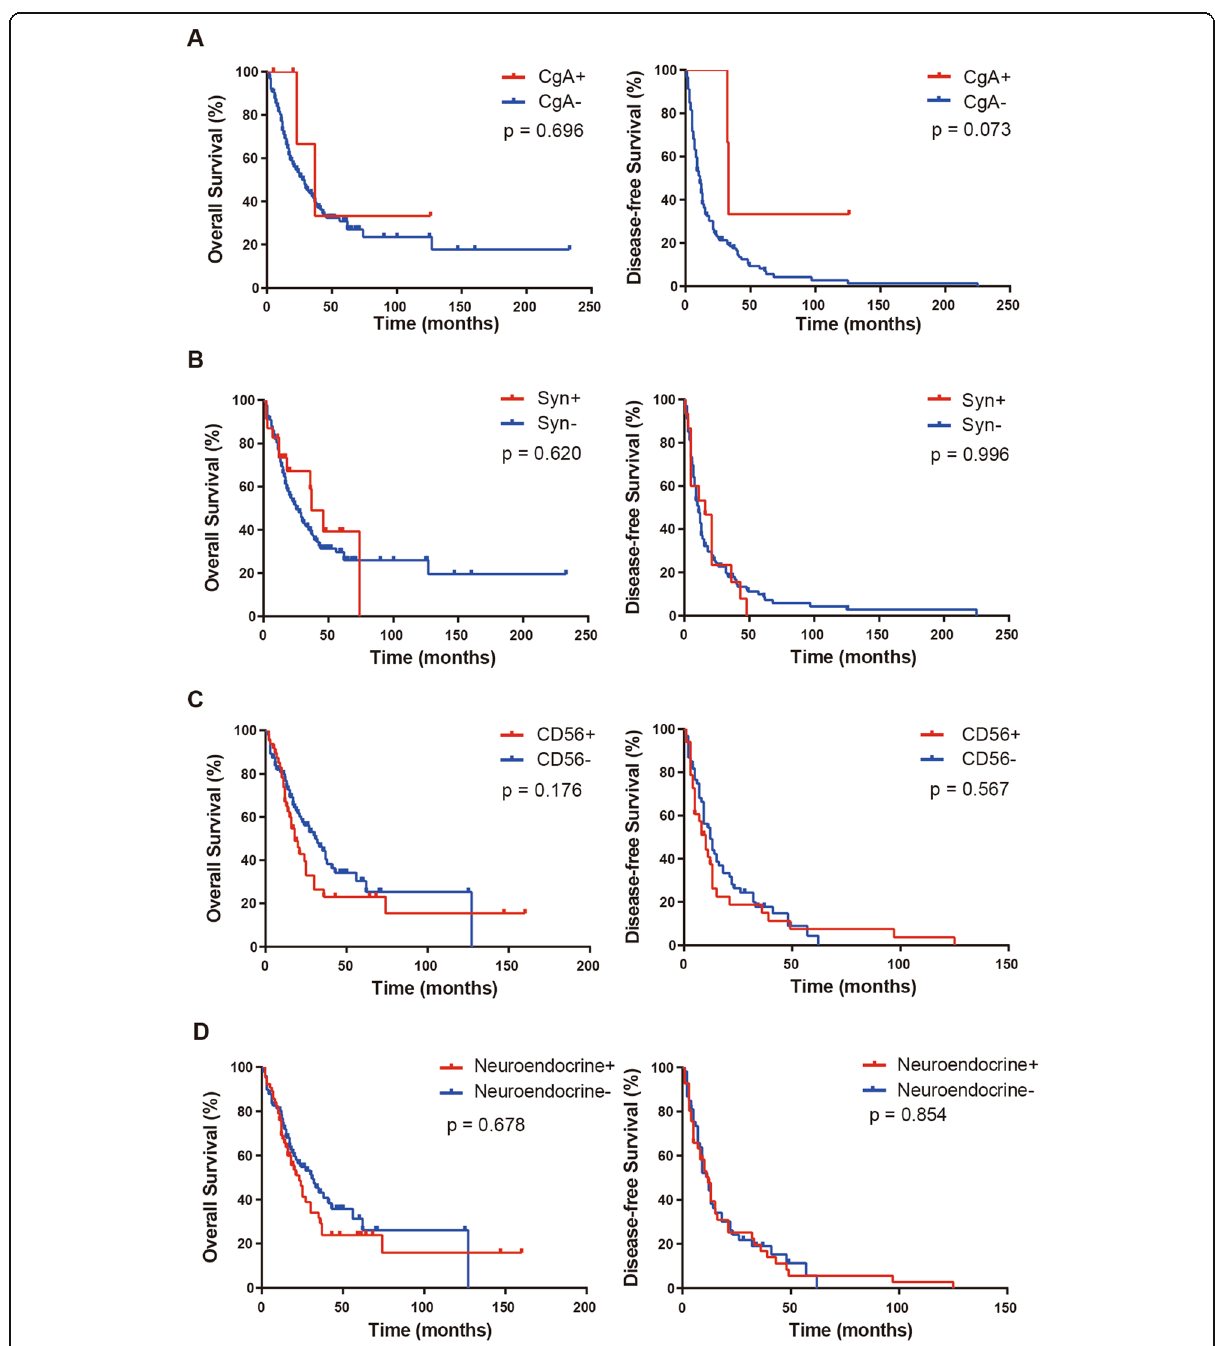
Fig. 2 Kaplan-Meier survival analysis of melanoma patients based on expression status of CgA, Syn, CD56 and any neuroendocrine